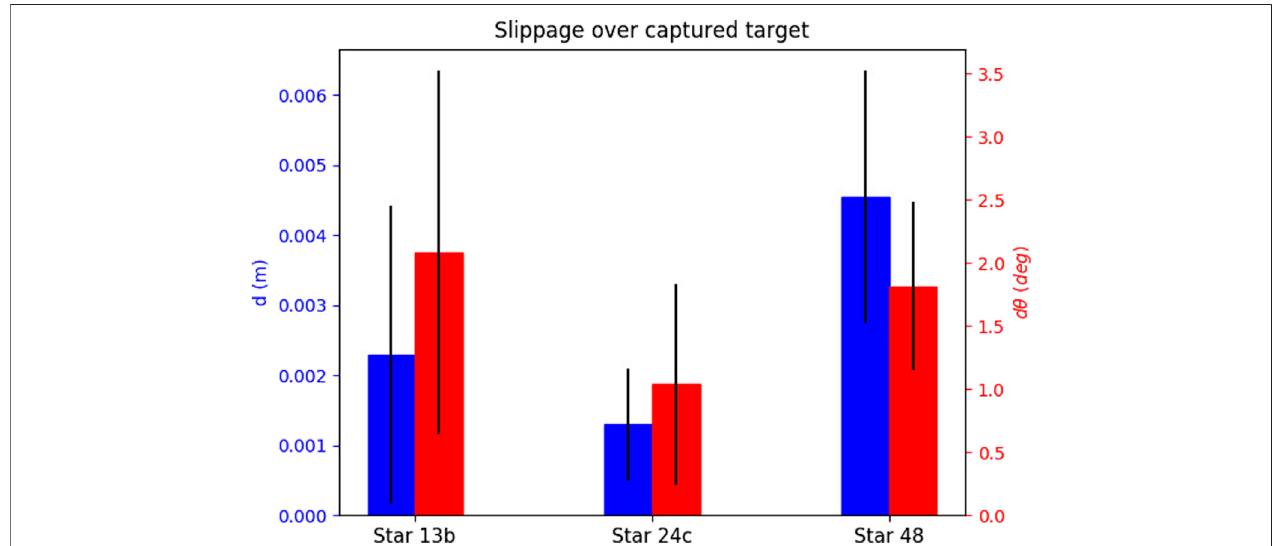
FIGURE 10 | The effect of the selected target on grasp stability for the simulation experiment.